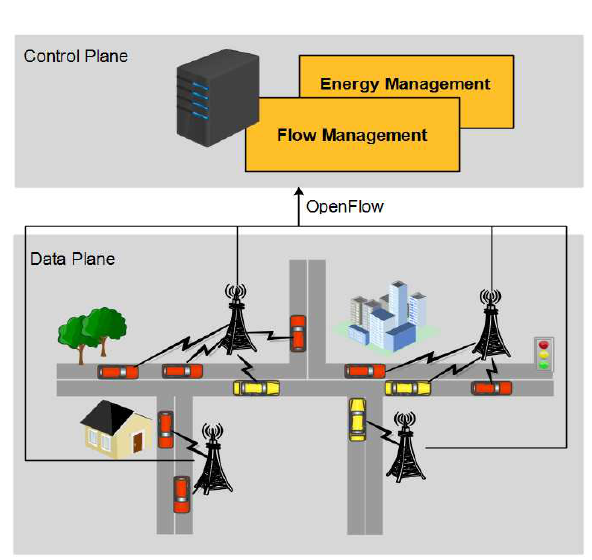
Figure 1. Considered energy-aware vehicular network architec-